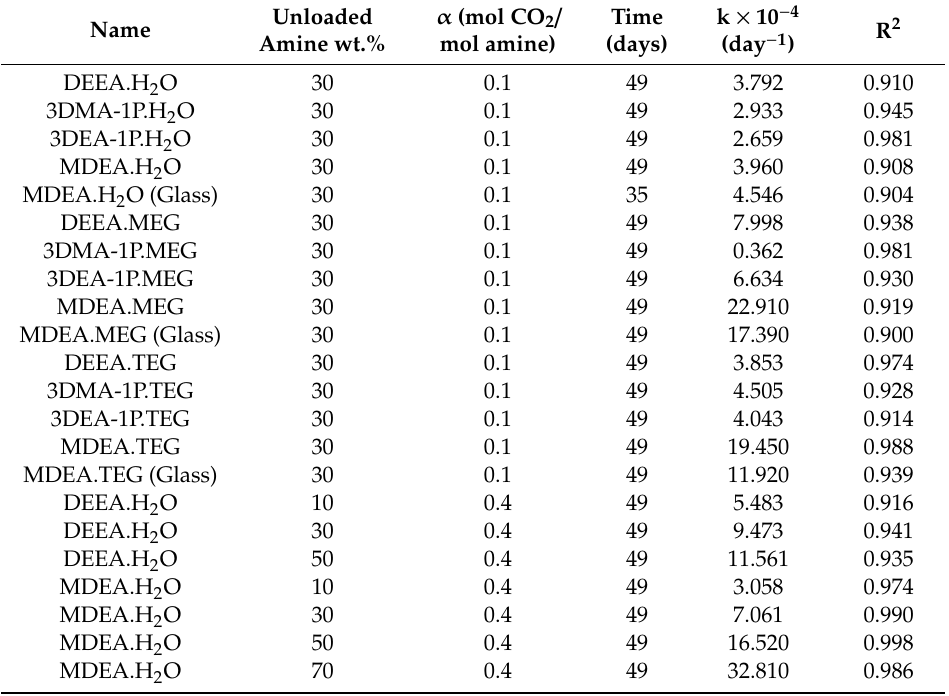
Table 2. Rate constants (k) and correlation factor (R 2 ) of all solutions, along with the experimental duration (time), CO 2 loading ( α ), and unloaded amine weight